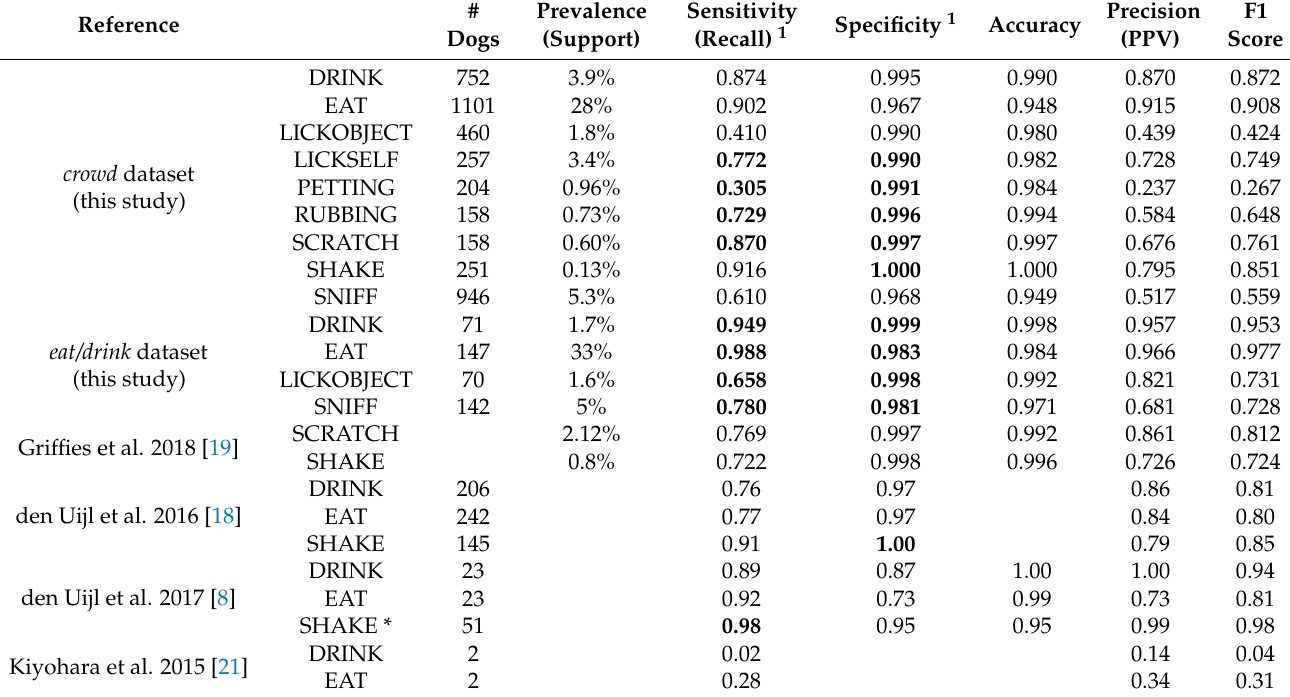
Table 9. Comparison of this work to other published results.